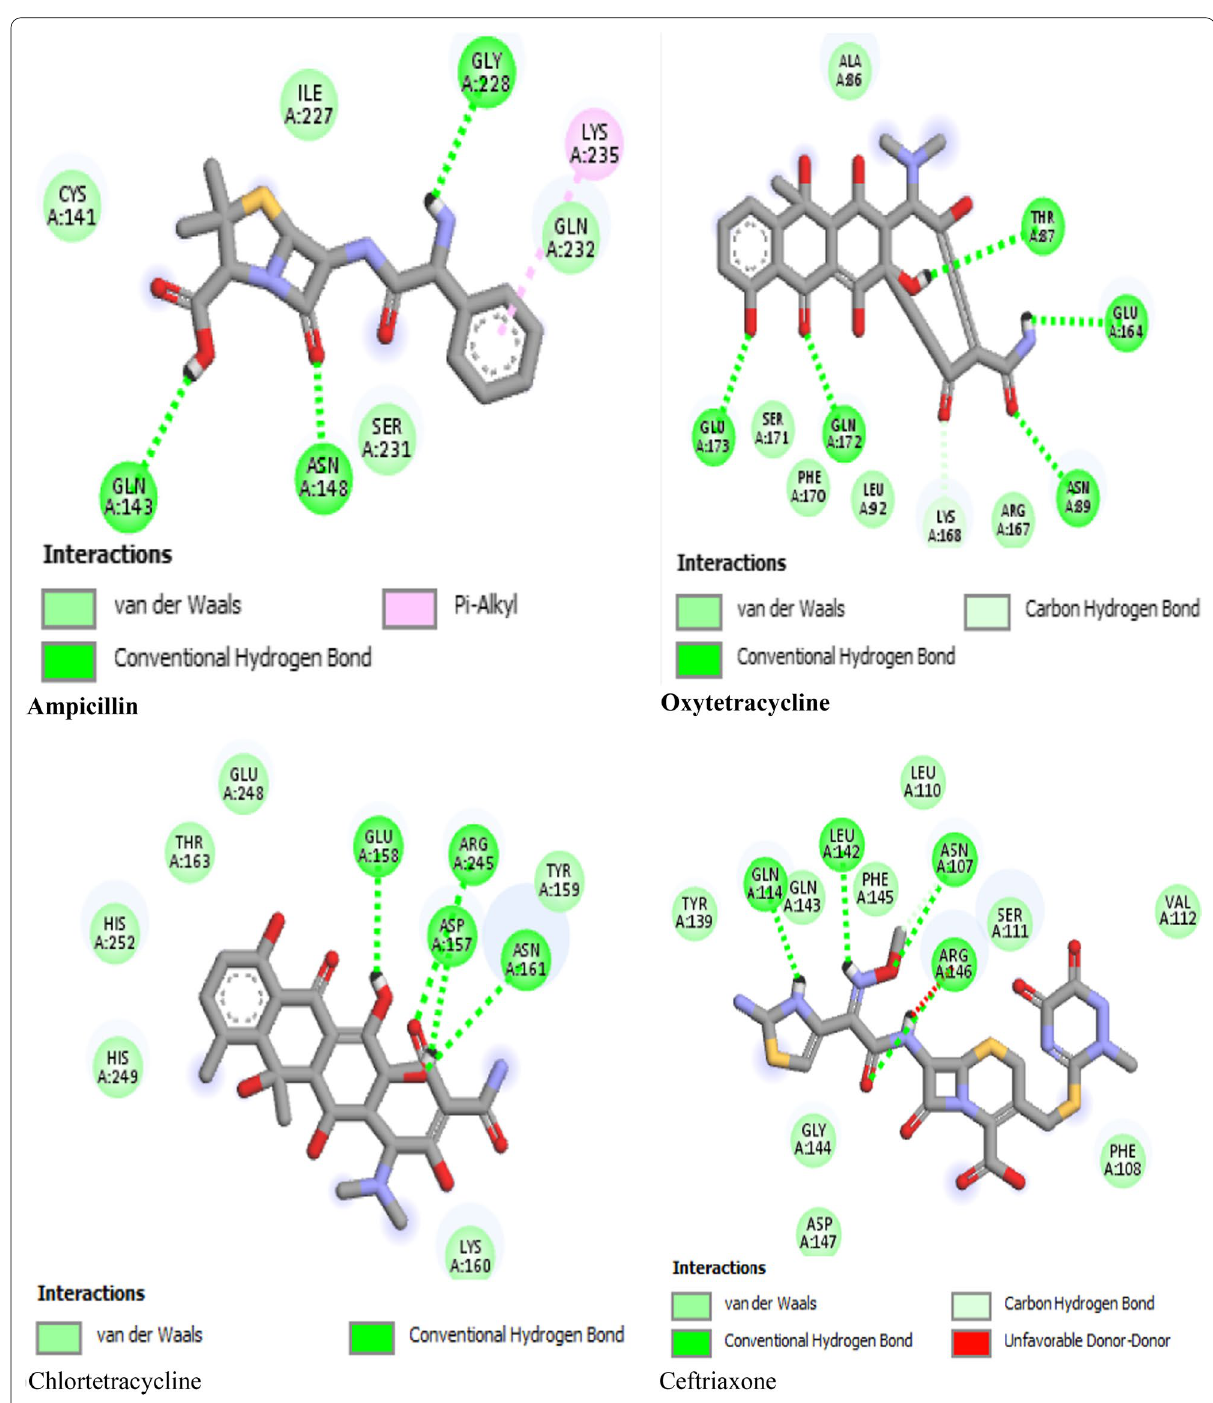
Fig. 5 Docking pose of the reference drugs into the active site of IncA membranes